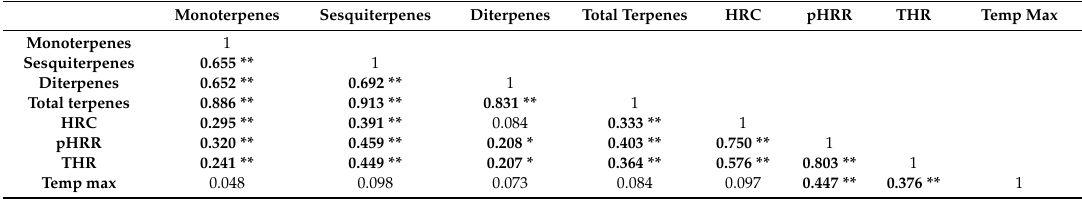
Table 3. Pearson correlations between terpene and flammability measurements for lab-dried needles across all seasons (n = 117). Significant correlations are in bold and the level of significance is indicated with asterisks (** p < 0.01; * p < 0.05). Monoterpenes Sesquiterpenes Diterpenes Total Terpenes HRC pHRR THR Temp Max